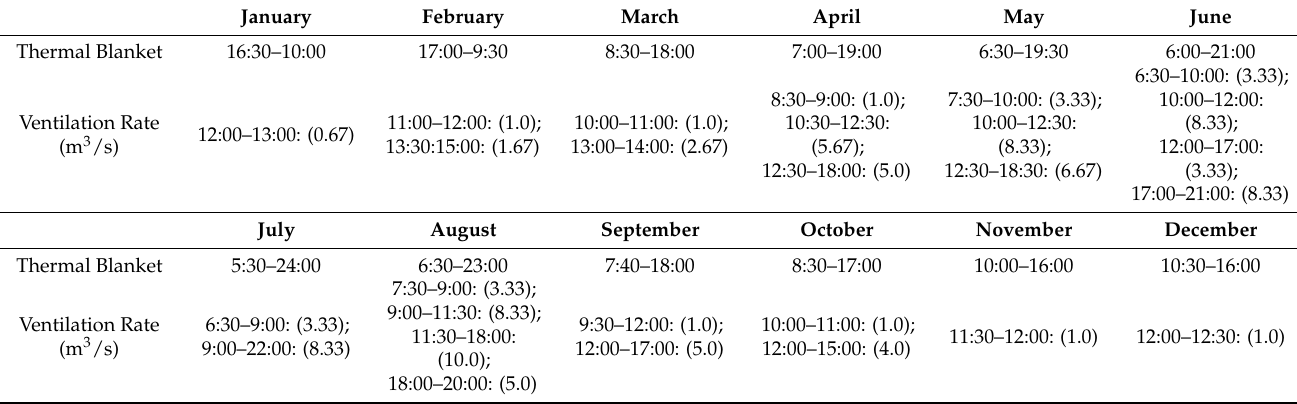
Table 3. The schedule for the thermal blanket and ventilation in the study